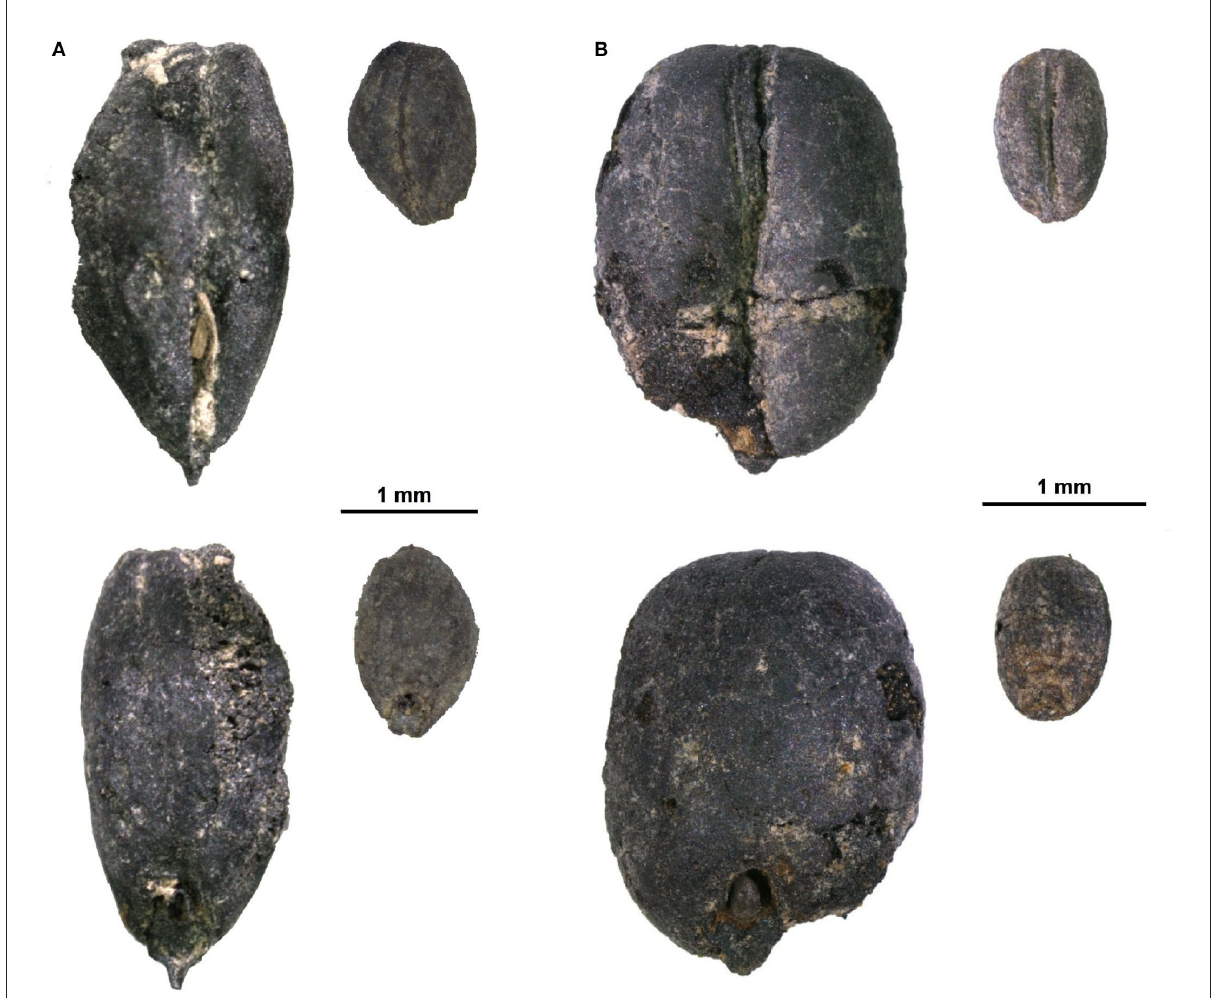
FIGURE4 Variation in size between caryopses of the same species of barley (A) and wheat (B) at Chap II